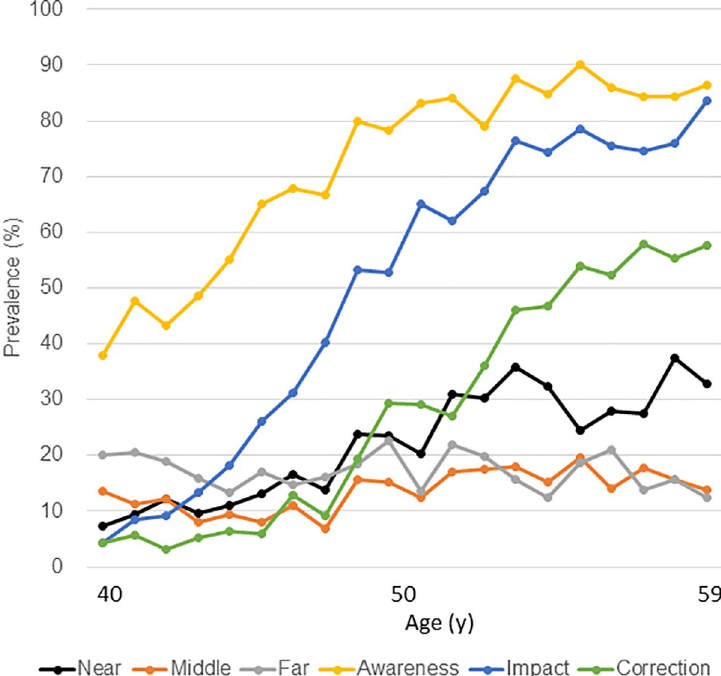
Fig 2. Prevalence of symptoms and burden with vision, and the proportion of near correction. The proportion of awareness of presbyopia was greater than that of impact across all ages surveyed. Awareness of difficulty focusing was age-dependent. The proportion of near correction was very low until age of 47 and then increased steeply. The severity of burden with near vision was apparently age-dependent, and burden with middle-distance vision were constant until increasing after age of 48, whilst burden with far vision was constant across all ages surveyed. Symbols and abbreviations: Near (black), burden with near vision; Middle (red), burden with middle-distance vision; Far (grey), burden with far vision; Awareness (orange), awareness of difficulty focusing; Impact (blue), reported impact of difficulty focusing; Correction (green), near correction.